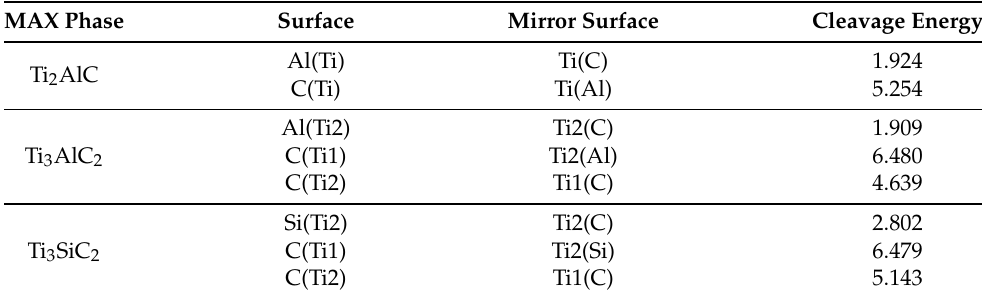
Table 3. Cleavage energies in eV/unit cell of each surface for each MAX